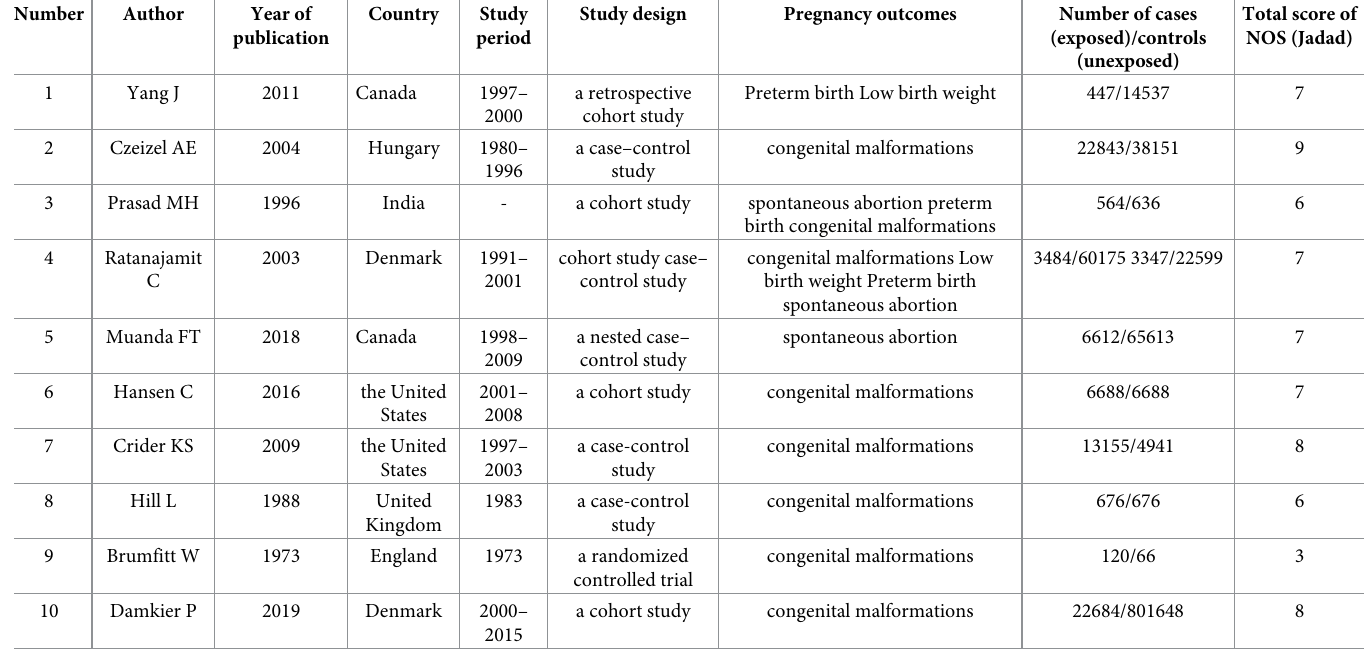
Table 1. The basic characteristics and effect values of the included studies.